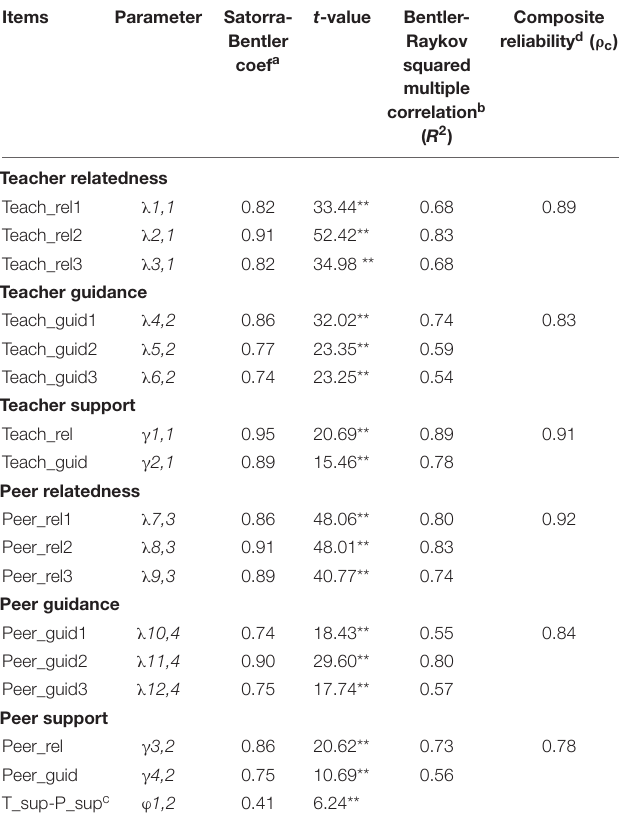
TABLE 1 | Measurement models for the first- and second-order factor models of teacher and peer support.